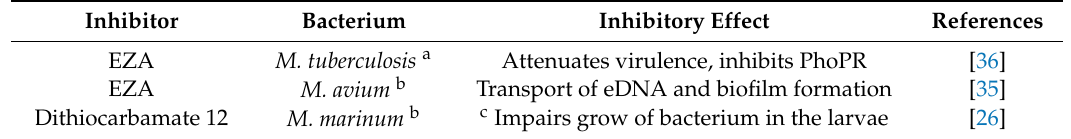
Table 4. Details of in vivo inhibition studies on different mycobacterial species.